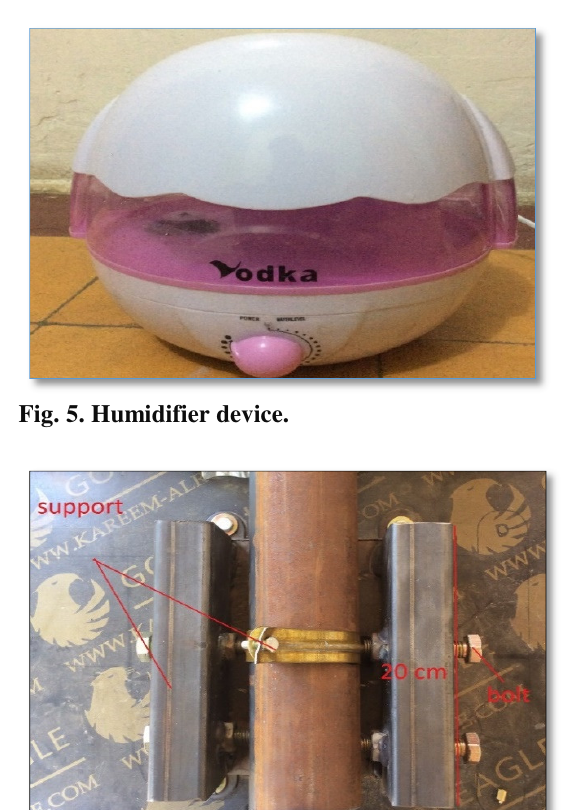
Fig. 9. Show number of cycle of 50cm